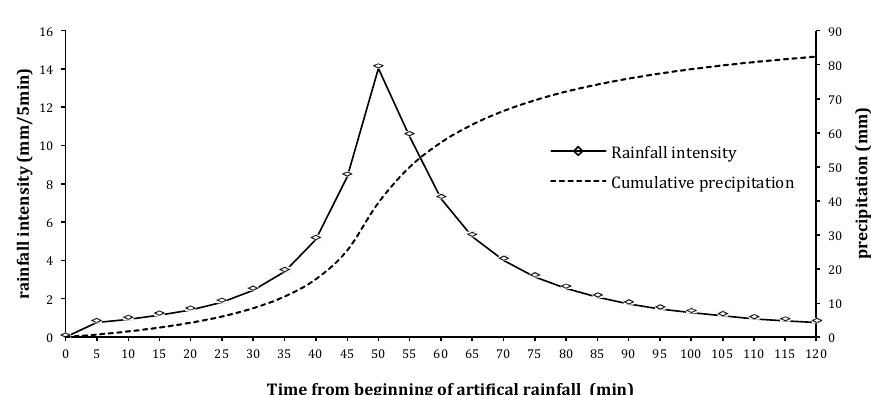
Figure 2. Artificial rainfall event design.